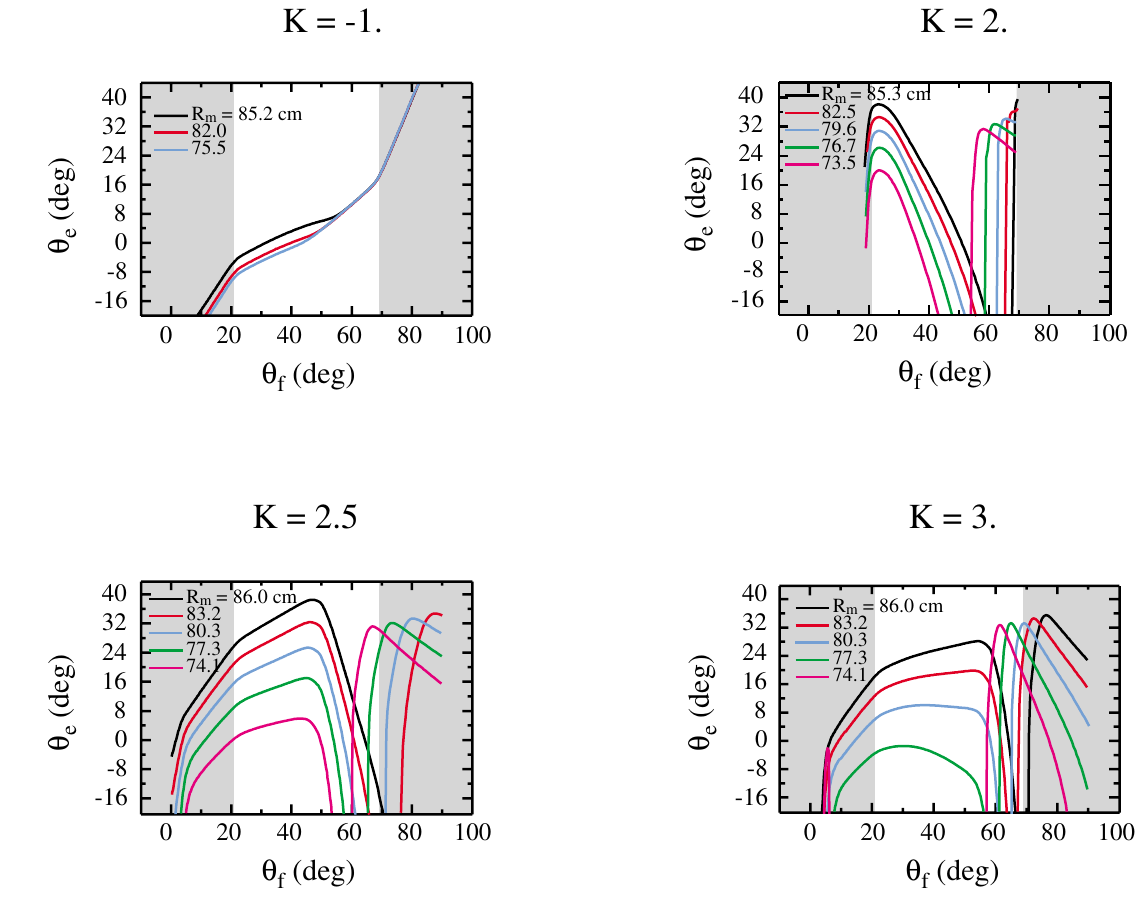
FIG. 3. (Color) Exit point dependence on foil position. A beam exit point from the cyclotron as well as a foil position is fully and (cid:6) , respectively. This is because the radial position of an exit point is R determined by their azimuthal coordinates, (cid:6) e f 1 : 6 m , as limited by the vacuum chamber size, while the foil is positioned along an equilibrium orbit defined by the orbit mean . The shaded areas depict the sector placement. The curve discontinuities in the graphs corresponding to positive ions radius R m ( K > 0 ) are caused by sector edge gradients and they mark transition from a single-loop to a double-loop ion trajectory after the